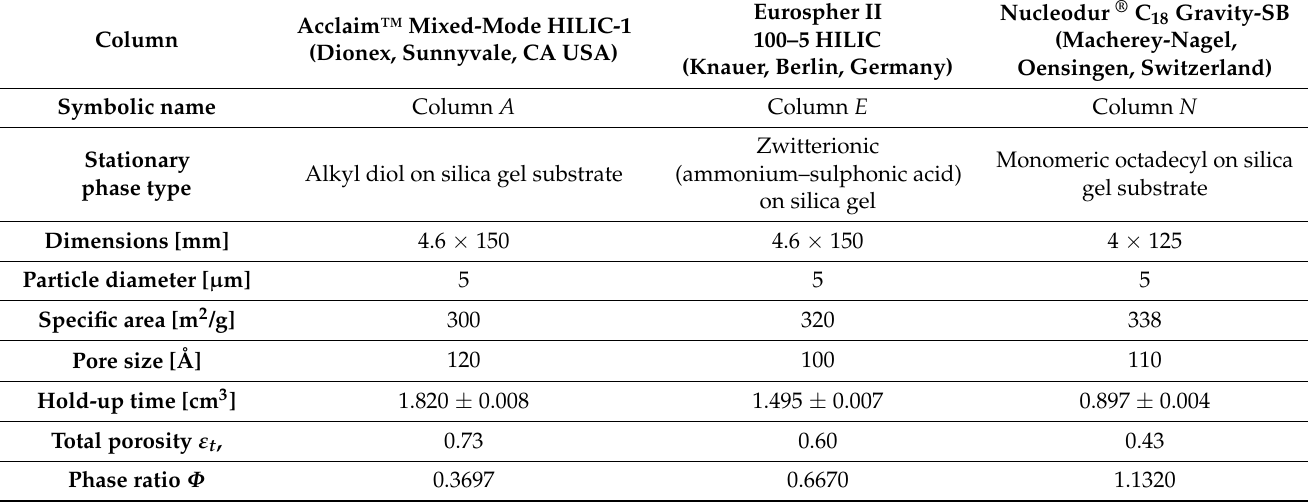
Table 1. Parameters of applied